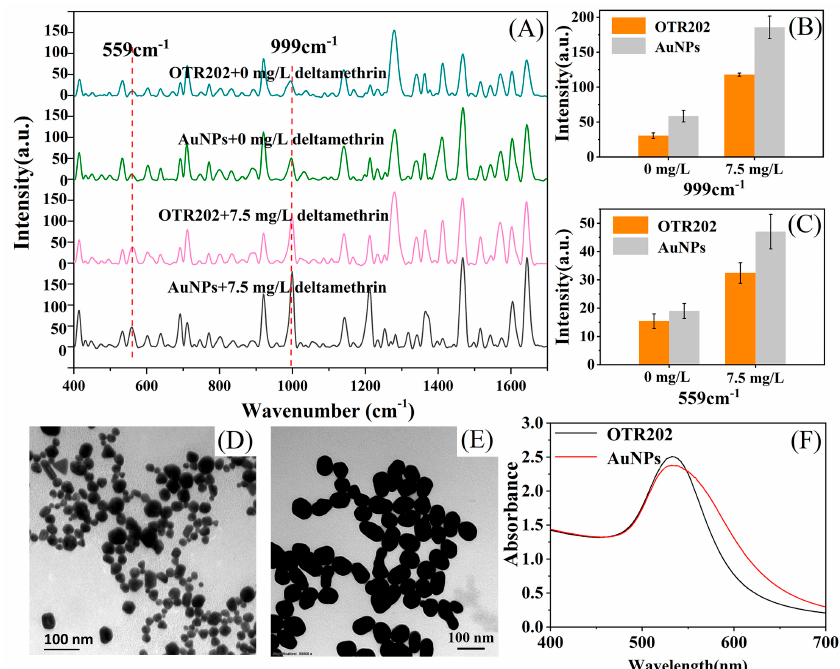
Figure 3. Surface-enhanced Raman spectroscopy (SERS) substrate characterization and comparison.